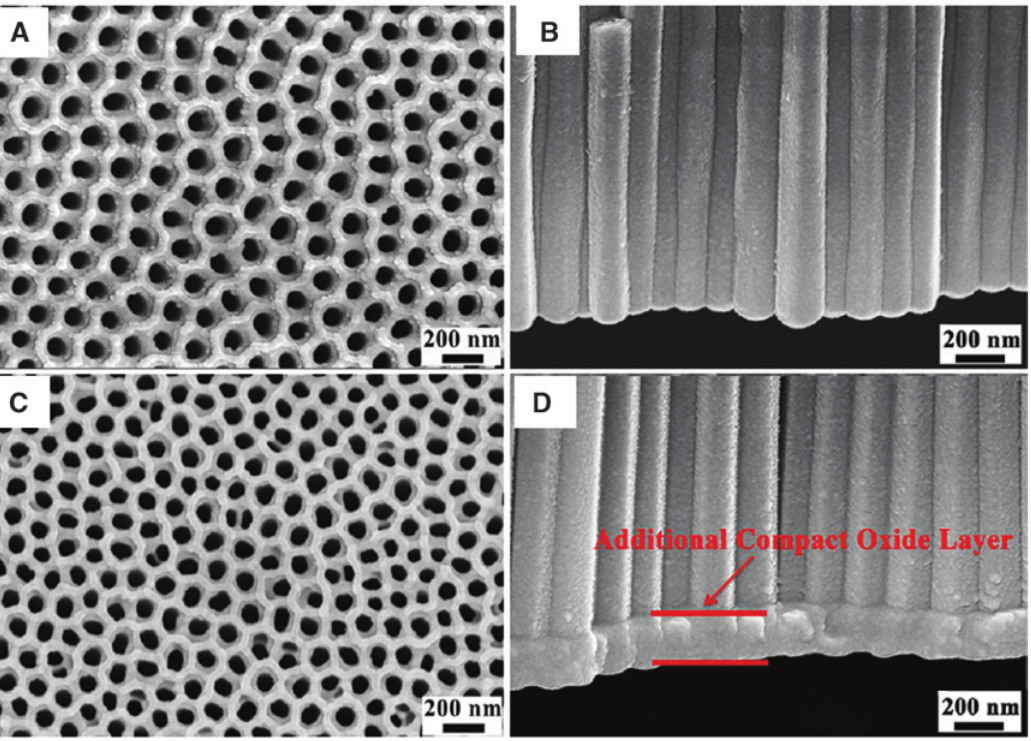
NTAs (A, B) 5 wt % NH F solution in ethylene glycol and (C, D) 2 4